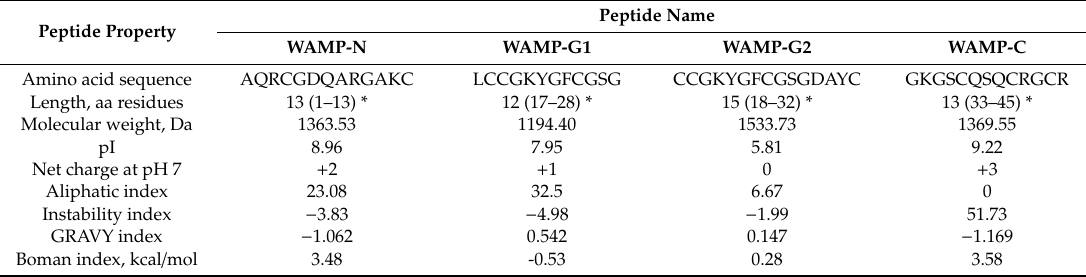
Table 2. Physicochemical properties of WAMP-2-derived